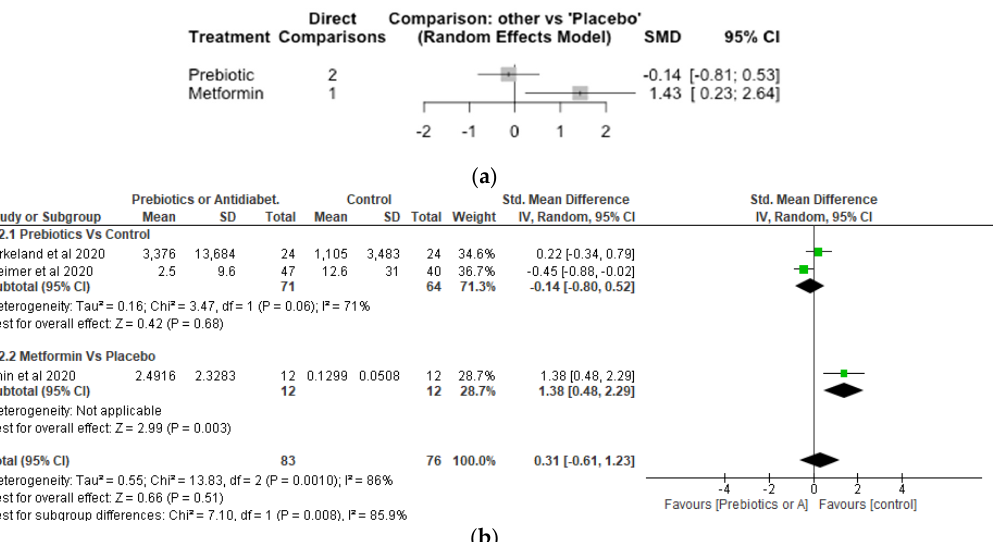
Figure 4. Network Meta-analysis ( a ) and Meta-analysis ( b ) of the effect of treatments versus control on Lactobaccilus